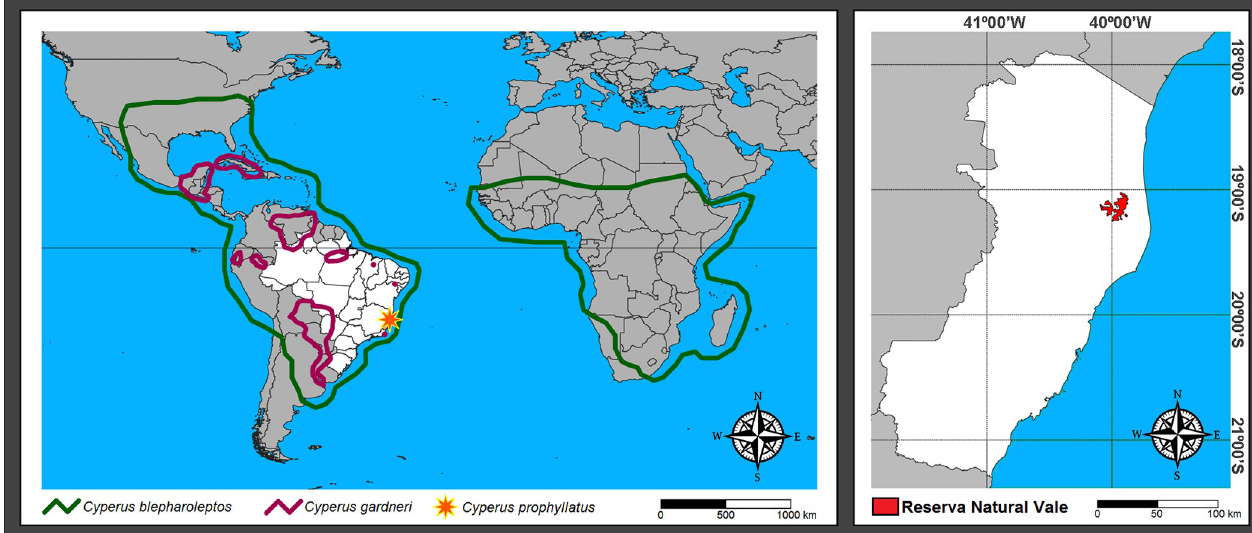
Fig 3. Distribution map of Cyperus prophyllatus , sp . nov ., and allied species.